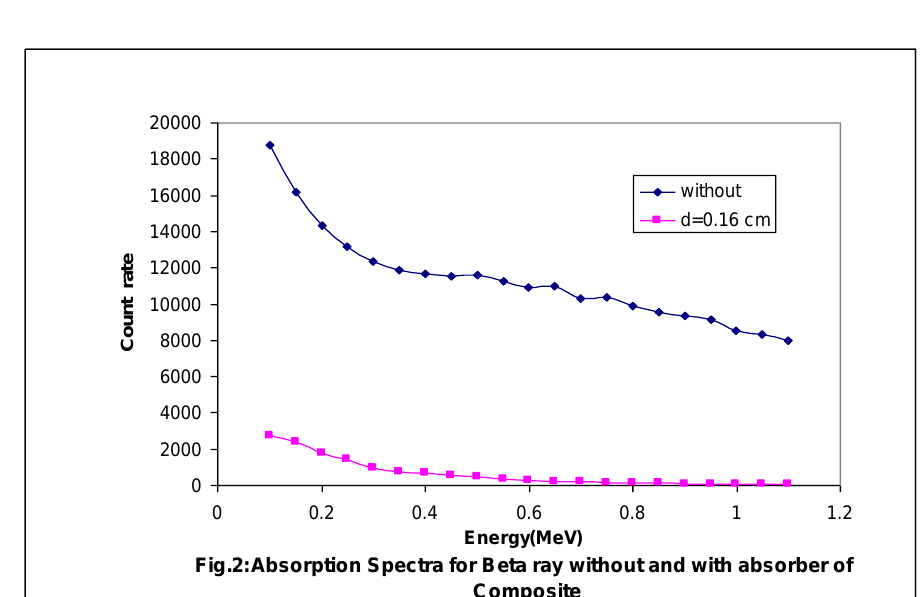
Fig.2:Absorption Spectra for Beta ray without and with absorber of